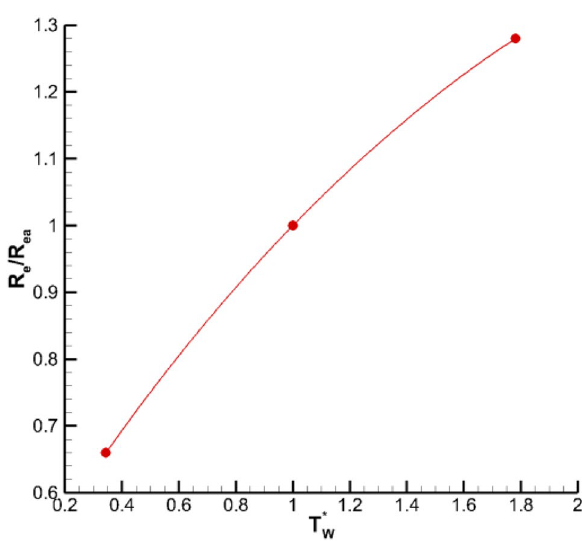
Figure 16. Variation of transition Reynolds numbers for z = 0.175